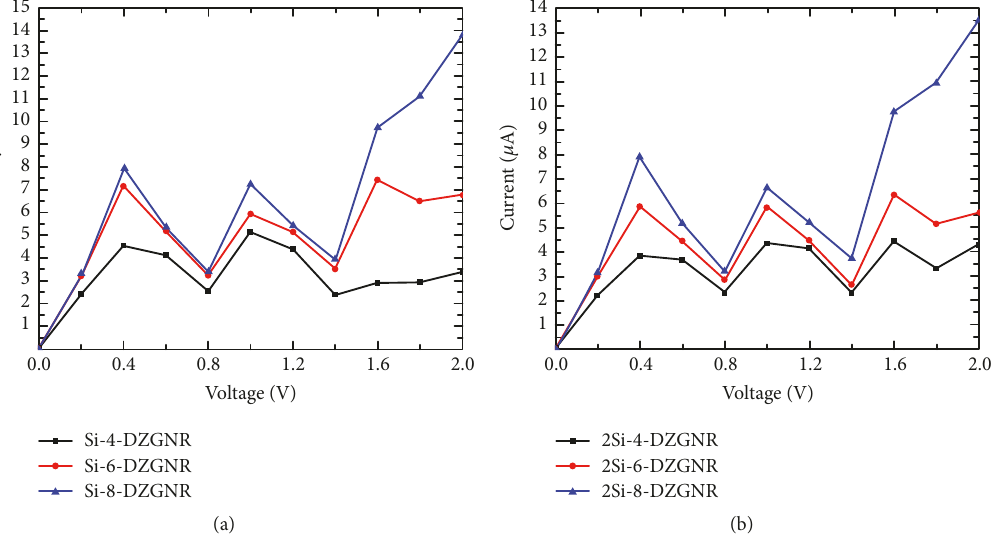
Figure 7: Calculated I-V curves for six structures: (a) Si-4-DZGNR, Si-6-DZGNR, and Si-8-DZGNR and (b) 2Si-4-DZGNR, 2Si-6-DZGNR, and